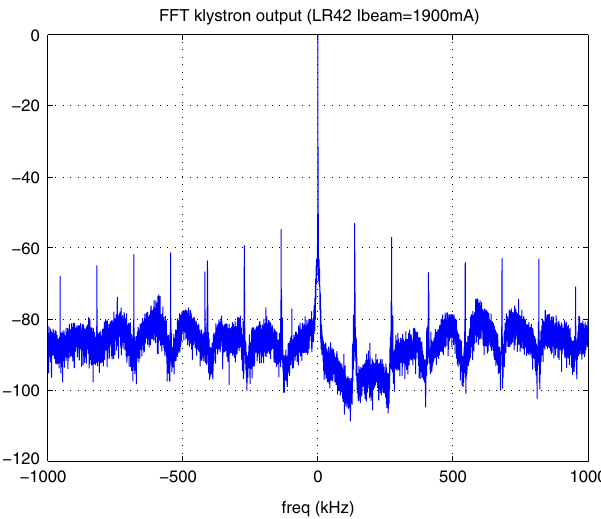
FIG. 20. (Color) Power spectrum of signals in the klystron out- put during closed-loop operation. (cid:4) 7 revolution harmonics are visible around the 476 MHz